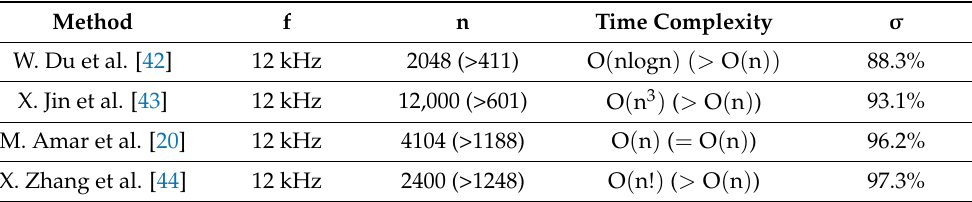
Table 8. Comparison with related